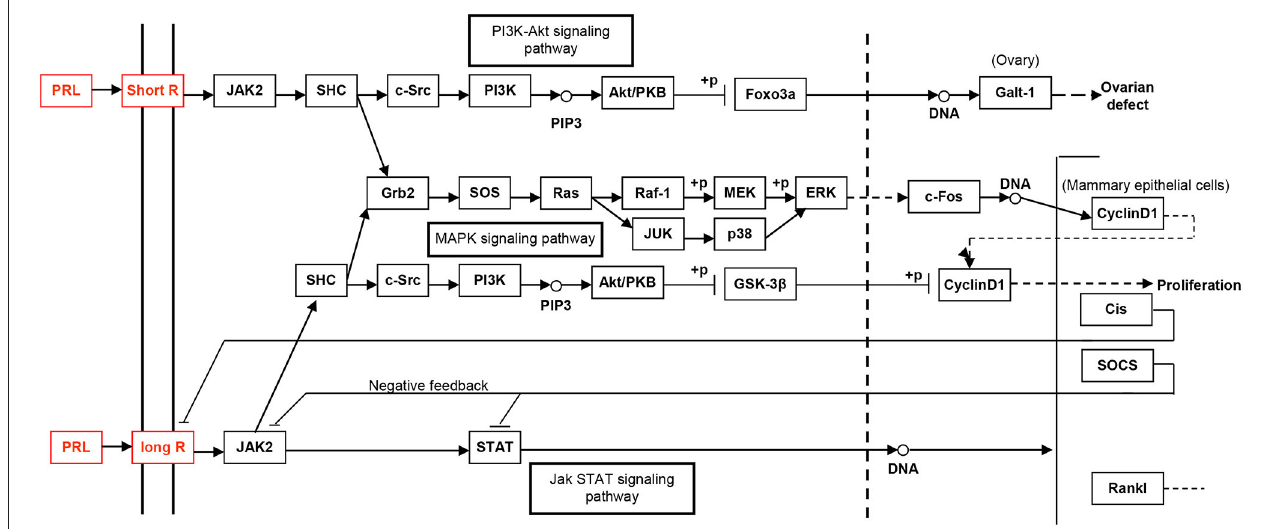
FIGURE 6 | The PRL-driven signaling pathways via the short or long PRL receptors, which was achieved from KEGG pathway database.